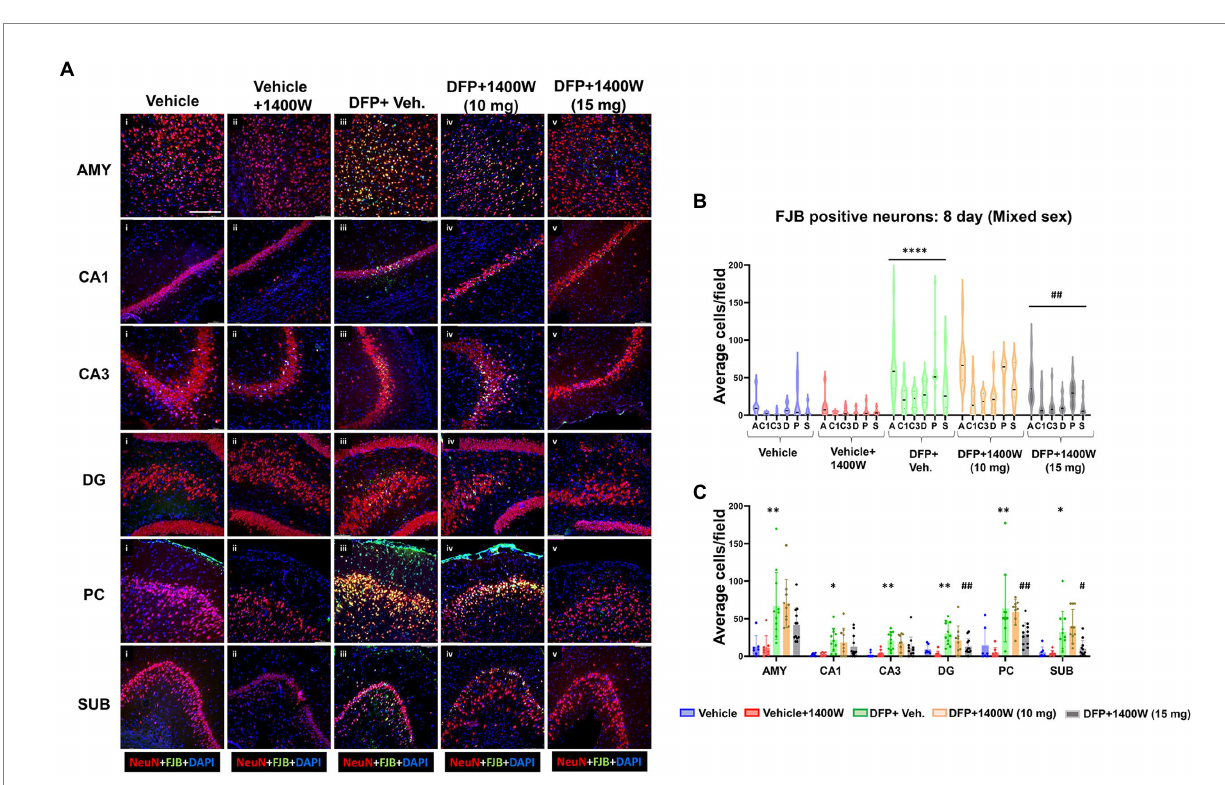
FIGURE 5 The effects of 1400W treatment for a week on DFP-induced neurodegeneration. Representative images of NeuN (red, neurons) and FJB (green) positive cells from Amygdala (AMY), CA1, CA3, Dentate gyrus (DG), Piriform Cortex (PC), Subiculum (SUB) regions are shown. Co-localized (orange) cells represent degenerating neurons. Sections were counterstained with DAPI (blue) to represent all nuclei, scale bar = 50 μ M (A) . Mixed effects model revealed a significant increase in degenerating neurons in brain as a whole in DFP + vehicle group and 1400W at 15 mg/kg significantly reduced the FJB positive neurons (B) .The two-way ANOVA analysis showed an increase in FJB positive neurons within different regions of the brain following DFP treatment and 1400W treatment significantly reduced FJB positive neurons at 15 mg/kg in DG, PC and SUB (C) . n = 7–12, Repeated measure Two-way ANOVA (mixed effects) with Tukey’s post-hoc for multiple comparisons. * Represents DFP effect compared to the vehicle (control); # represents the 1400W effect compared to DFP + vehicle group * represents DFP effect compared to vehicle (control) and # represents 1400W effect compared